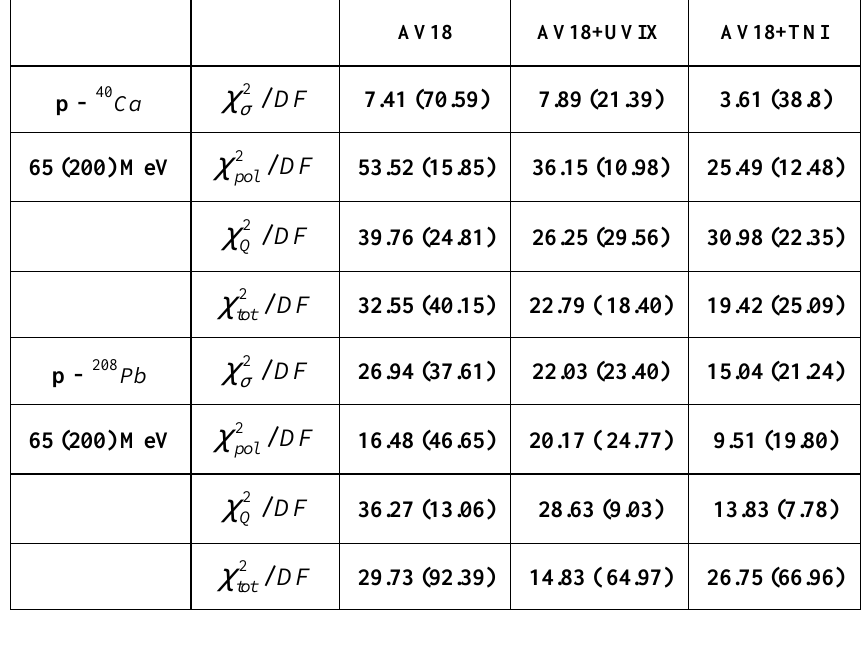
c DF Table 1: The 2 / : X s = , pol, Q and tot represent the differential cross section, analyzing X power, spin rotation and total cross section respectively for the experimental data